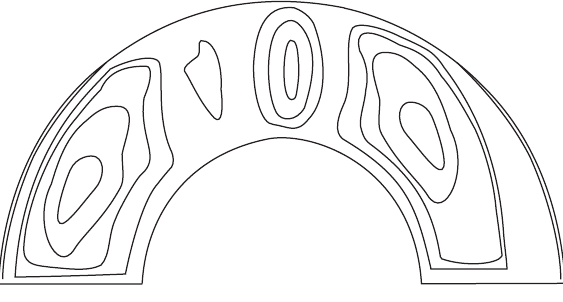
Figure 4.8. Asymmetric Taylor vortex at Re =